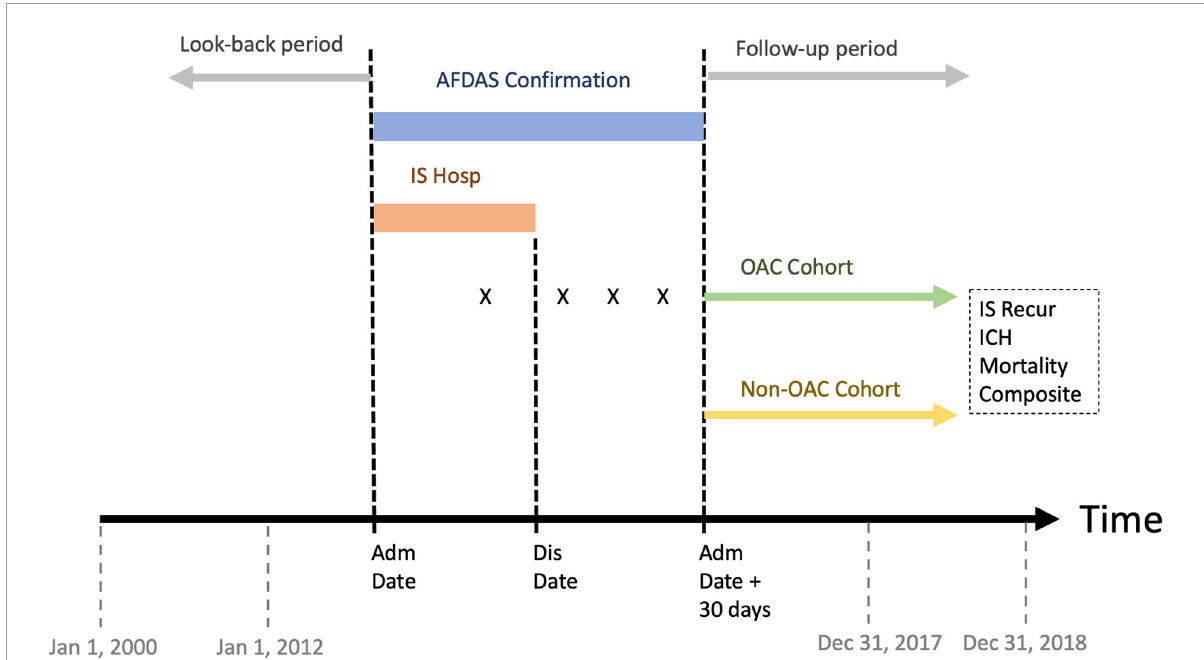
FIGURE1 Study design. AFDAS, atrial fibrillation detected after stroke; Hosp, hospitalization; X, prescription of oral anticoagulant; Adm, admission; Dis, discharge; OAC, oral anticoagulant; IS Recur, ischemic stroke recurrence; ICH, intracranial